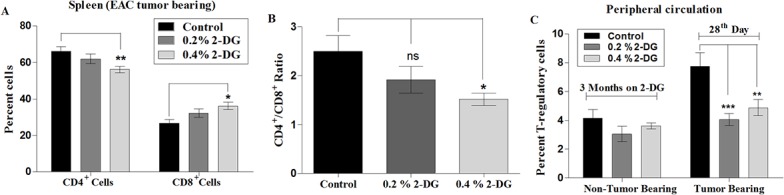
Effect of 2-DG on T-cell populations.(A) 2-DG had a differential and dose dependent effect on CD4+ (decrease) and CD8+ (increase) T-cell subpopulations reflected in reduced (B) CD4+/CD8+ ratios. Lymphocytes from the spleen of control and 2-DG fed EAC tumor bearing mice were analyzed by flowcytometry to quantitate percentages of CD4+ and CD8+ populations. Also the effect of 2-DG administration on the (C) CD4+CD25+ Treg cell population was determined in the peripheral circulation of non tumor bearing and EAC tumor bearing host by flowcytometry. 2-DG prevents tumor-induced augmentation of CD4+CD25+ Treg cells in tumor-bearing mice compared to no alteration in the non tumor bearing mice. *, p < 0.05; **, p < 0.01; ***, p < 0.001